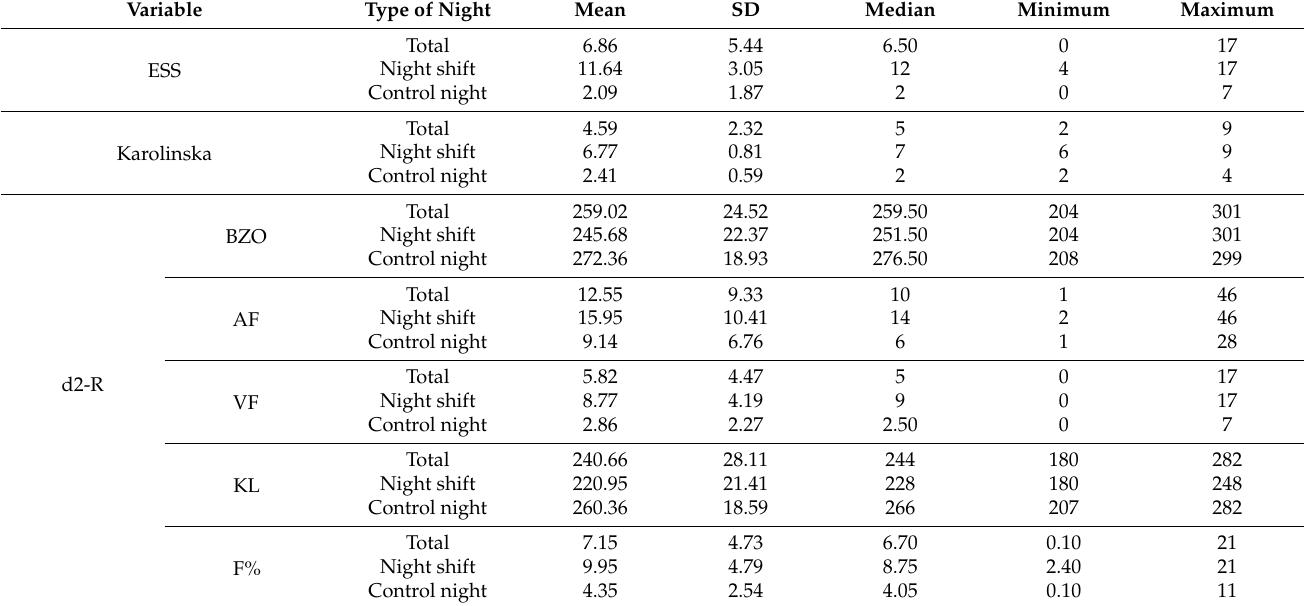
Table 4. Daytime sleepiness and concentration ability after the control night, the night shift, and in total. AF, “Auslassungs- fehler“/omissions, BZO, “bearbeitete Zielobjekte”/number of completed objects; CI, confidence interval; ESS, Epworth Sleep Scale; F%, „Fehlerquote“/mistake rate; KL, “Konzentrationsleistung”/concentration, SD, standard deviation; VF, “Verwechslungsfehler”/mix-up mistakes. Variable